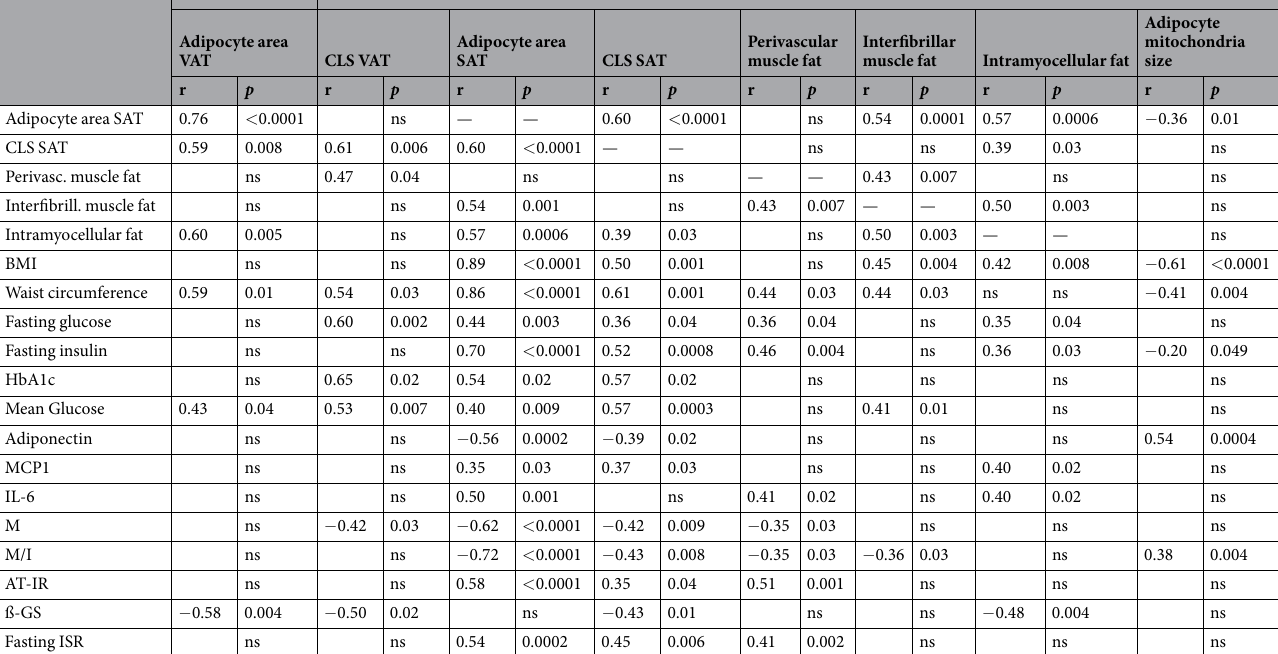
Table 3. Correlation among clinical, histological, and metabolic parameters in the combined ND and T2D